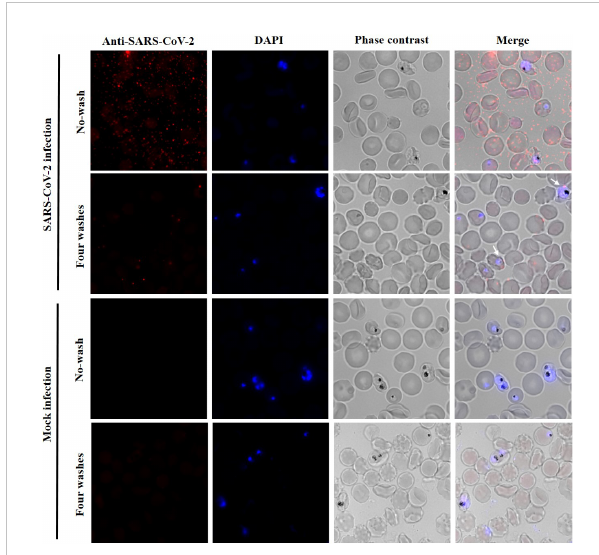
FIGURE 4 Low adhesion or entry of SARS-CoV-2 to P. falciparum infected erythrocytes. Immuno fl uorescence analysis with an anti-SARS-CoV- 2 nucleocapsid antibody. P. falciparum culture at 5.5% parasitaemia was incubated with SARS-CoV-2 at MOI of 2 or with infection medium without virus (mock infection). No washed and four washed samples were analysed. P. falciparum DNA was stained with DAPI. Erythrocytes were visualized by phase contrast (gray). Maximum intensity projections of three-dimensional stacks are shown for red and DAPI channels. The percentage of P. falciparum infected erythrocytes with viral particles (red dots) attached after four washes was calculated counting several fi elds with a total of 3,418 red blood cells (9.13%; SD